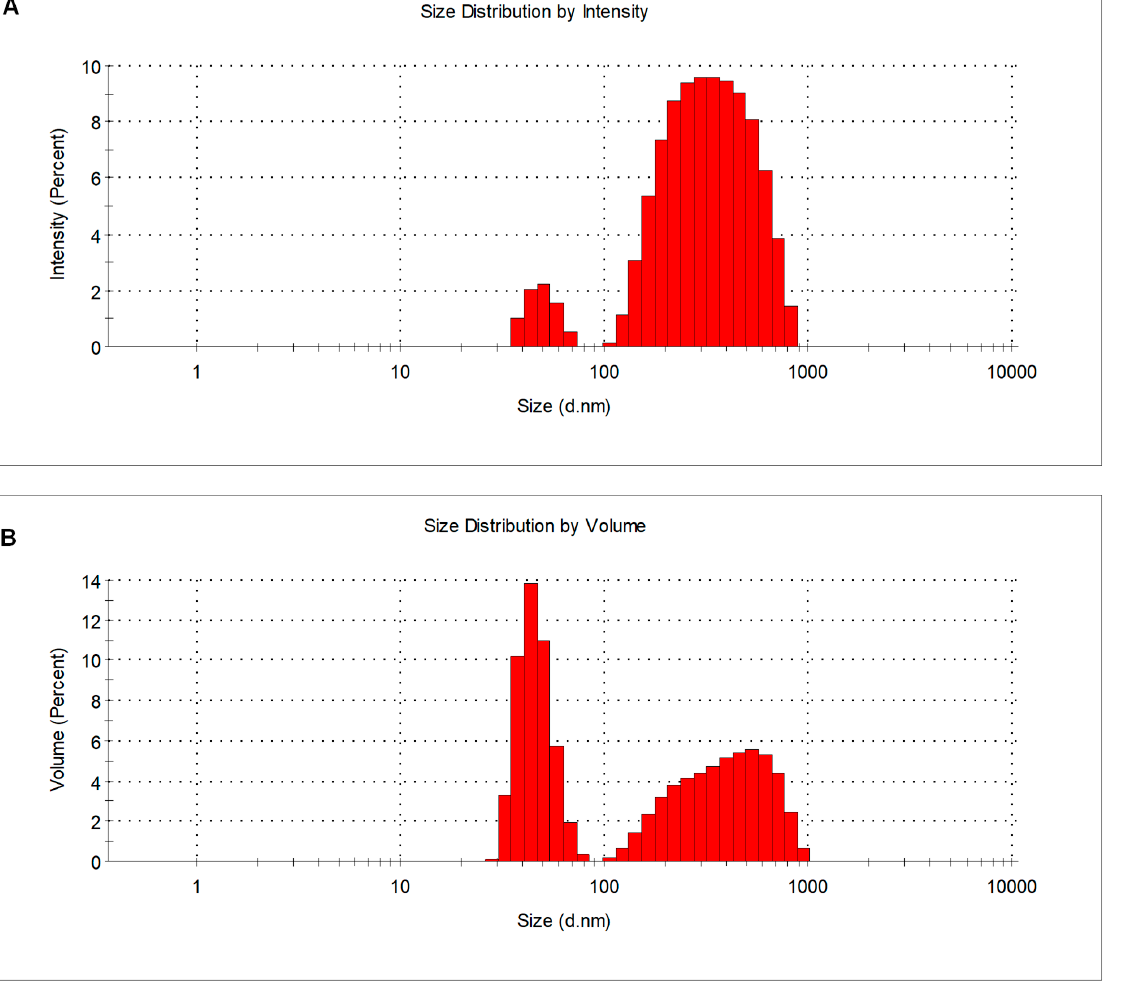
Figure 2. DLS size distribution analysis of 1 mg mL − 1 CSNPs solution by ( A ) intensity and ( B ) volume.